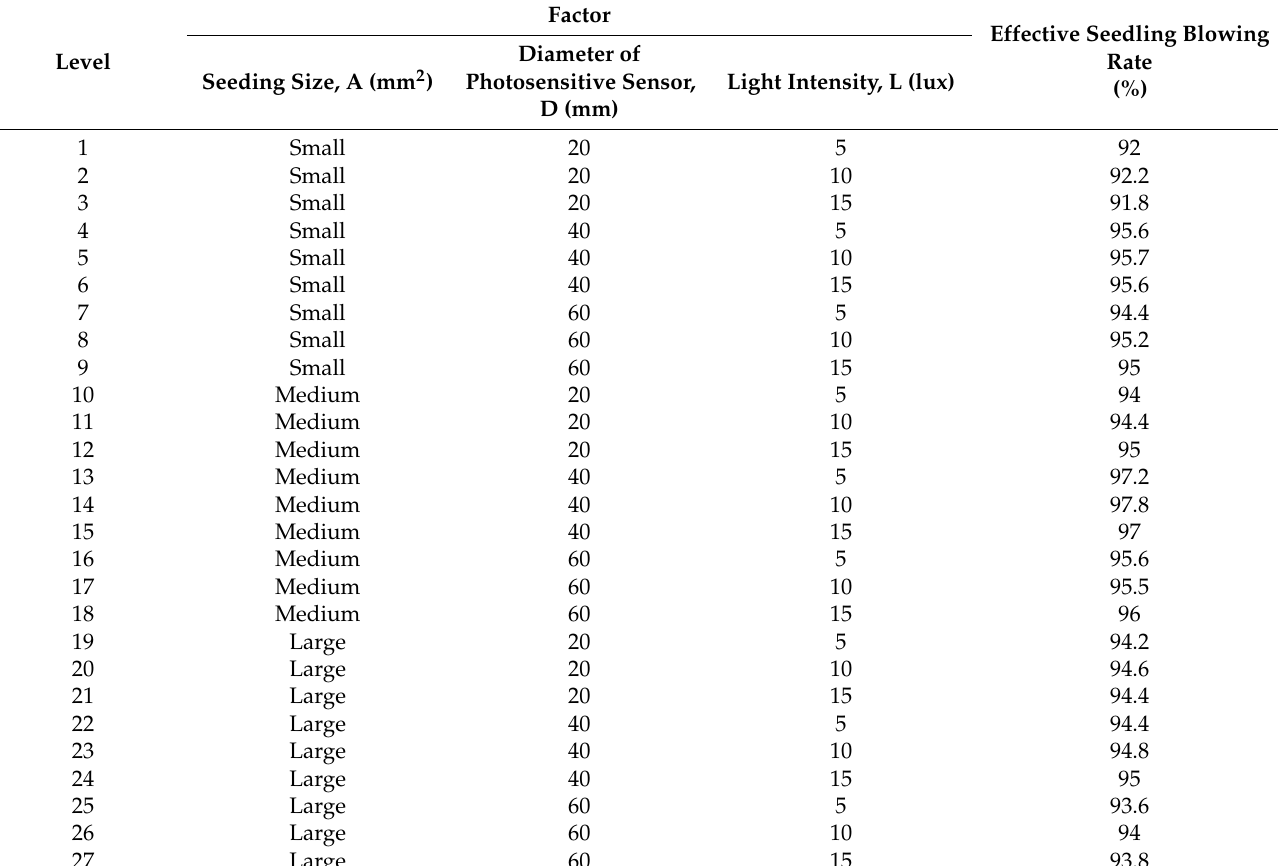
Table 2. Orthogonal test results.